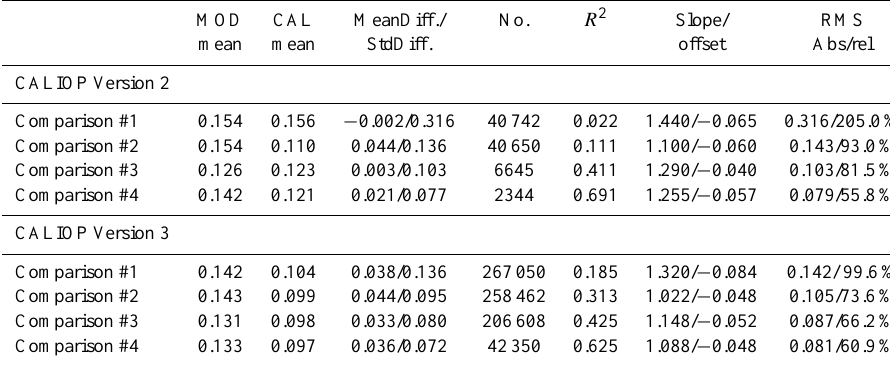
Table 9. MODIS vs. CALIOP AOD532, October 2009,